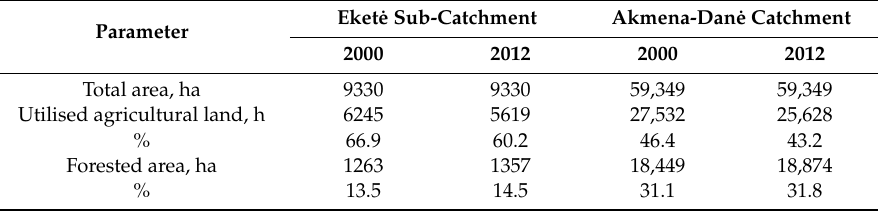
Table 3. Land use data according to CORINE database in the Akmena-Dan ė catchment and the Eket ė sub-catchment in 2000 and 2012.